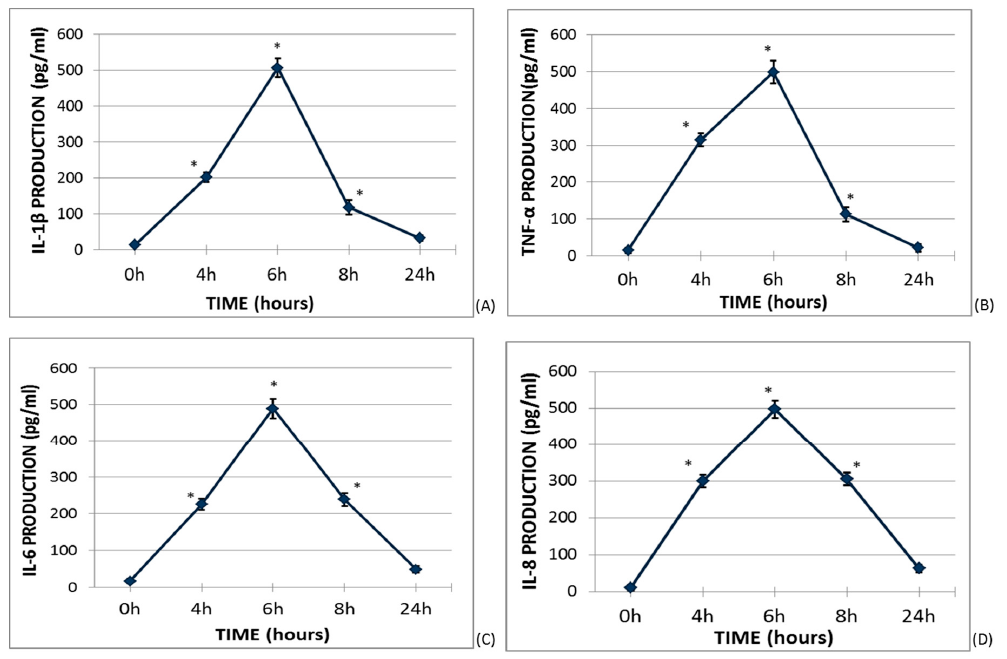
Figure 1. Cytokine production curves in lipopolysaccharide (LPS)-stimulated whole blood. One milliliter of whole blood was incubated in the presence of LPS (0.5 µ g / mL) in darkness and continuously shaken at 37 °C. The supernatant concentrations of interleukin (IL)-1 β , tumor necrosis factor α (TNF- α ), IL-6, and IL-8 were measured by ELISA at 0, 4, 6, 8, and 24 h of culture. The diamonds and vertical segments represent the mean ± SEM of six different donors. * p < 0.05 represents a significant difference each time the measurement was compared to baseline production.